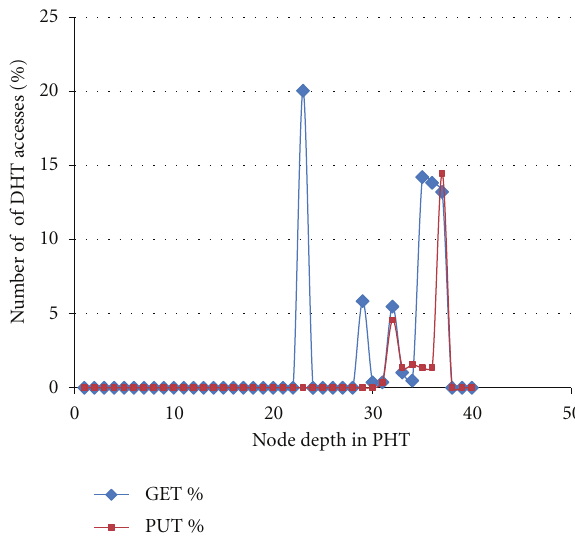
Figure 7: PHT structural properties: block utilization.